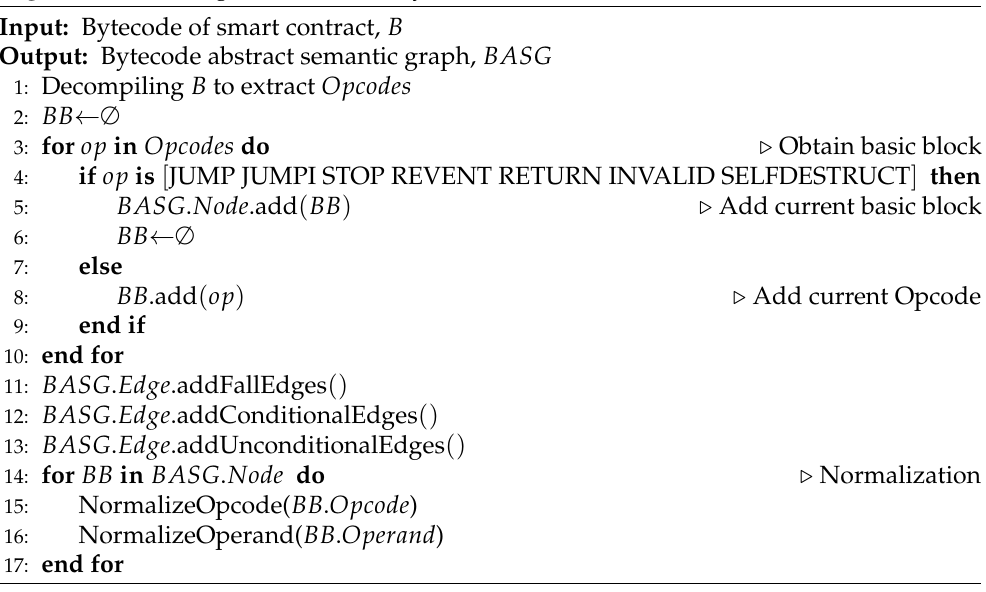
Algorithm 2 BASG generation from